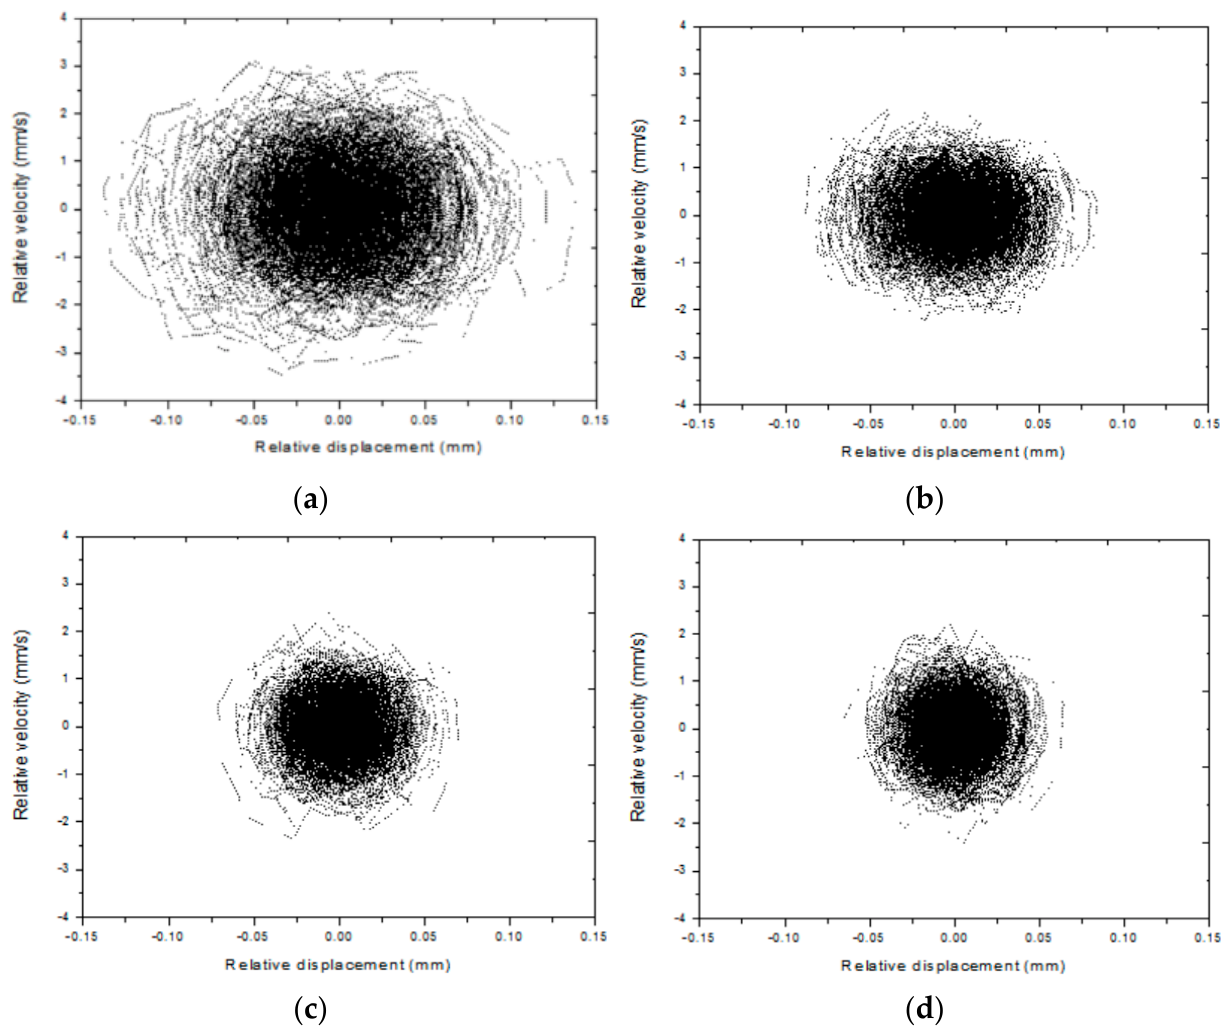
Figure 9. Relative Phase-Plane Curves of “Adjacent” Measuring Points at Soil-Pile Cap Interface under White Noise: ( a ) Before earthquake, ( b ) After earthquake of small level, ( c ) After earthquake of medium level, ( d ) After earthquake of high level.